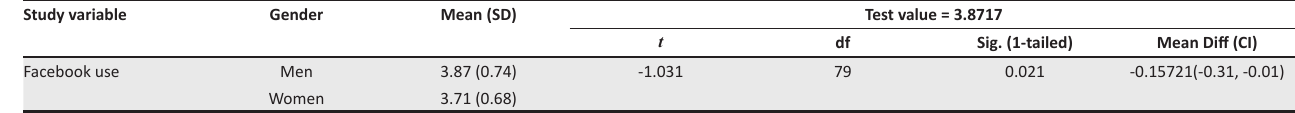
TABLE 5: One-samples t -test for mean gender differences on Facebook